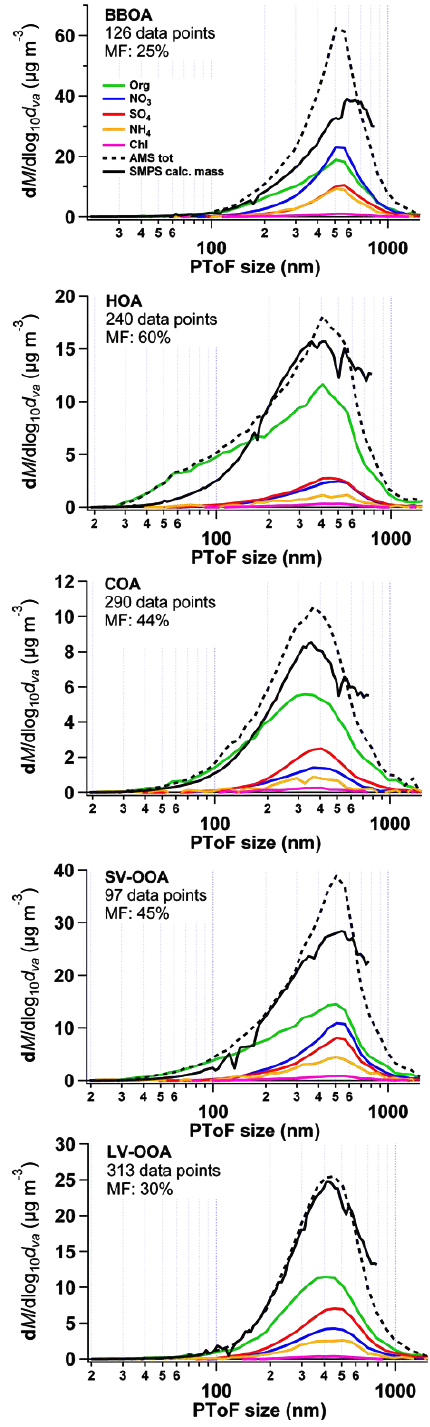
Fig. 5. Size distributions of PM 1 components for periods with high LV-OOA, SV-OOA, COA, HOA or BBOA. The number of data points averaged and the organic mass fraction (MF) of the respec- tive factor during those data points are given. Total AMS mass and SMPS data of the same time periods were added for